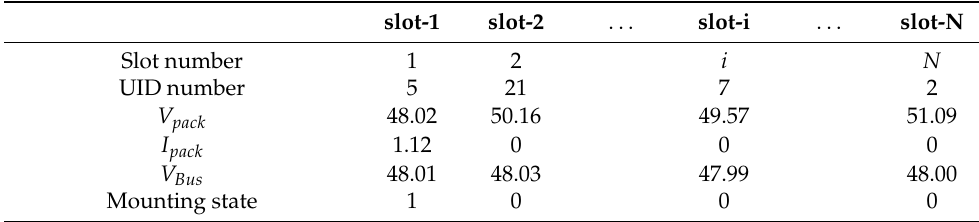
Table 1. Example of a simplified PMT.